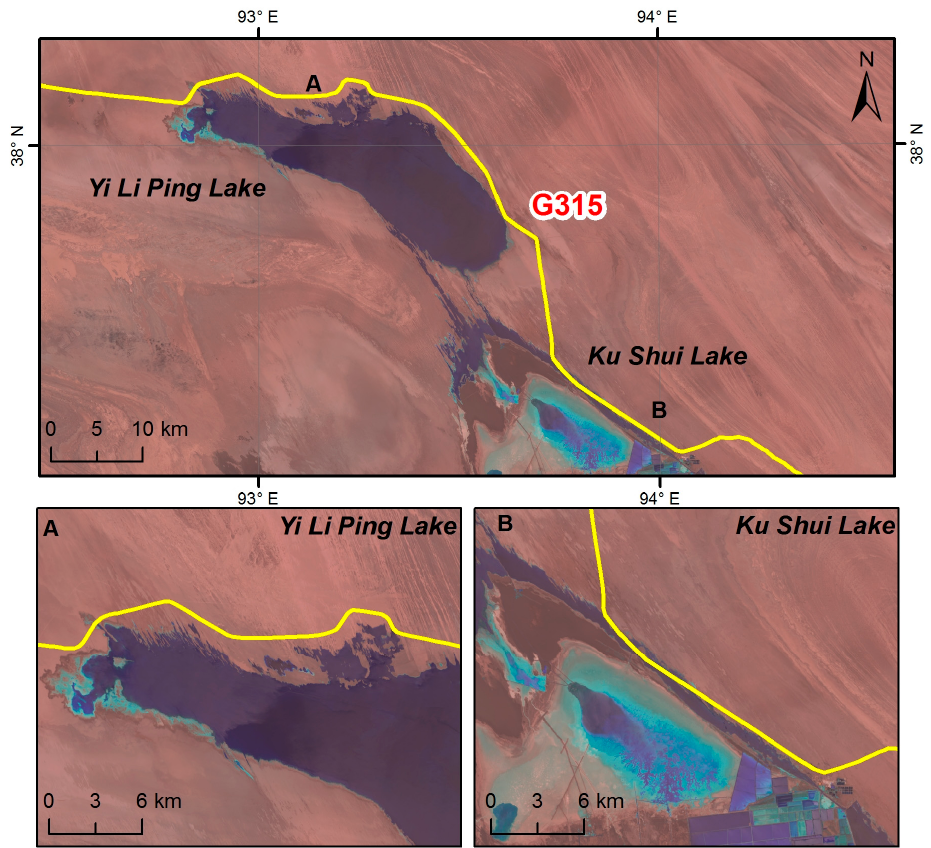
Figure 13. Expanding salt lakes inundated the high way G315.